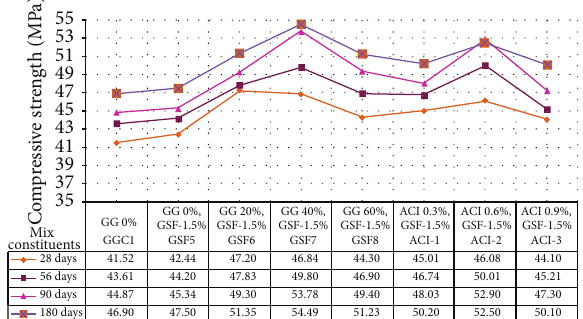
Figure 9: Flexural strength of concrete specimens for alternate wetting and drying cycles for various concrete mixes (subjected to 40% initial stress).